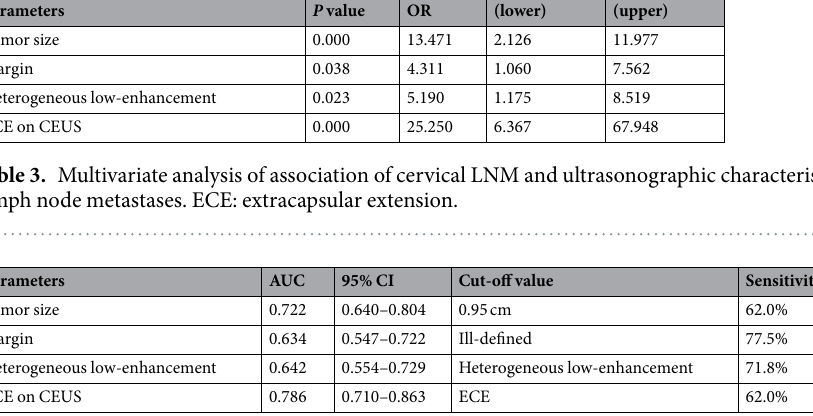
Table 4. ROC analyses of the independent parameters in identifying cervical LNM from patients with PTCs. LNM: lymph node metastases. ECE: extracapsular extension. AUC: area under curve.